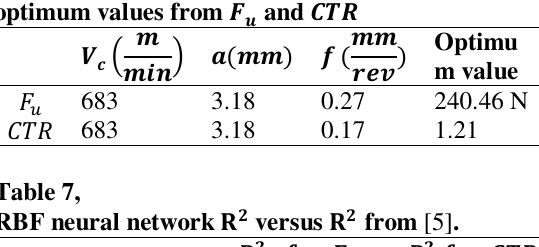
The optimum parameters and their corresponding